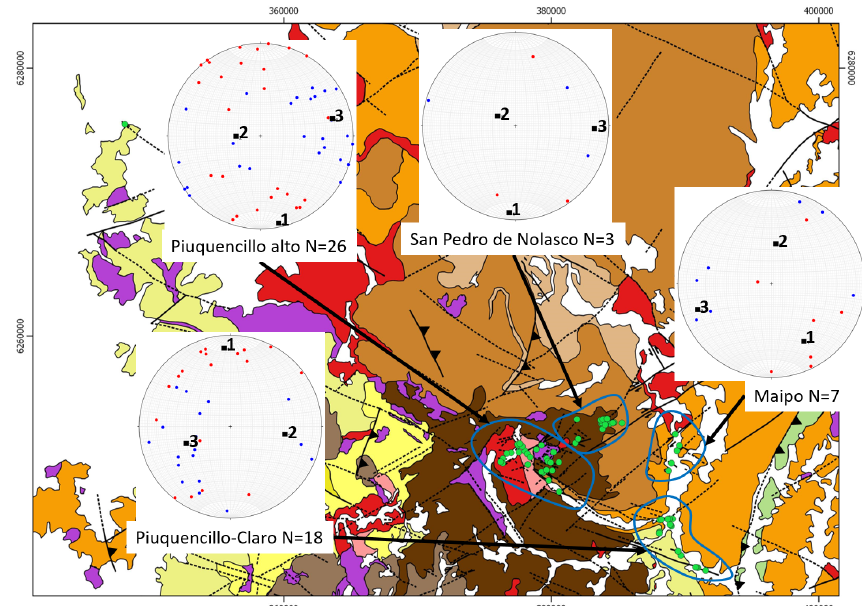
Figure 12. Kinematic analysis of fault-plane data by sector. Clarillo–La Obra sector is not considered, as no reliable kinematic indicators were found. The geological map in the background was compiled from Rivera and Cembrano (2000), SERNAGEOMIN (2002), Fock (2005), Fock et al. (2005), Piquer (2015) and this